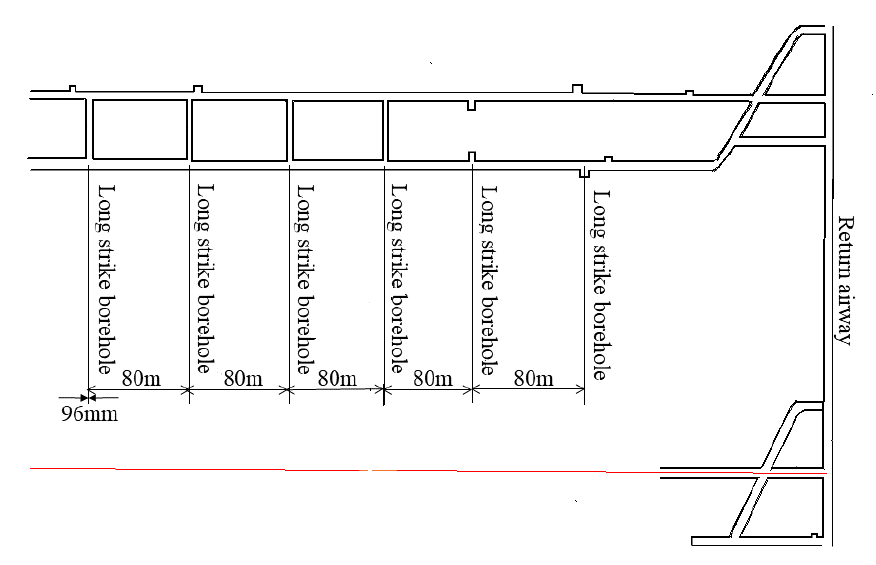
Figure 5. The location of long strike borehole.